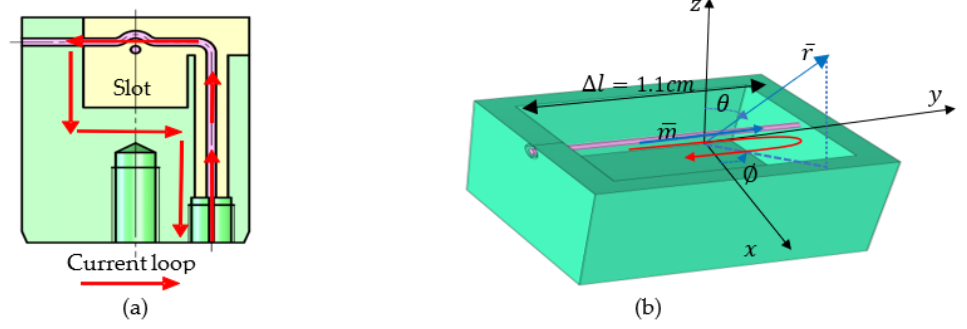
Figure 3. Schematic diagram of slot antenna: ( a ) working principal diagram of antenna; ( b ) antenna equivalent model.